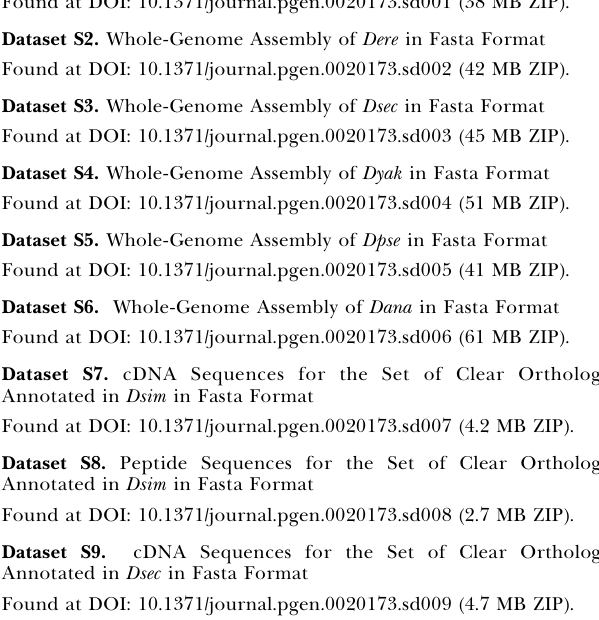
Figure S1. Significance of Incongruence under Six Evolutionary Models An excess of incongruence above what is expected by chance was observed for genes from Dmel, Dere, Dyak, and Dana using the HKY model (A), the HKY þ G model (B), the F3 3 4 model (C), the F3 3 4 þ G model (D), the WAG þ F model (E), and the WAG þ F þ G model (F). Genes were binned by bootstrap value, and the proportion of genes supporting tree 1 (red line), tree 2 (green line), and tree 3 (purple line) were plotted. The expected congruence based on the bootstrap value in each bin (black solid line) demonstrates the excess incongruence. Found at DOI: 10.1371/journal.pgen.0020173.sg001 (829 KB EPS). Figure S2. Significance of Incongruence for 20 Species Combinations An excess of incongruence above what is expected by chance was observed using the HKY model for genes from Dmel, Dsec, Dsim, Dere, Dyak, Dana, and Dpse (A), Dmel, Dsec, Dsim, Dere, Dyak, and Dana (B), Dmel, Dsec, Dsim, Dere, Dyak, and Dpse (C), Dmel, Dsec, Dere, Dyak, Dana, and Dpse (D), Dmel, Dsim, Dere, Dyak, Dana, and Dpse (E) , Dsec, Dsim, Dere, Dyak, Dana, and Dpse (F), Dsec, Dere, Dyak, Dana, and Dpse (G), Dmel, Dsim, Dere, Dyak, and Dana (H), Dsim, Dere, Dyak, Dana, and Dpse (I), Dmel, Dsec, Dere, Dyak and Dana (J), Dsim, Dere, Dyak, and Dana (K), Dsec, Dsim, Dere, Dyak, and Dana (L), Dsec, Dere, Dyak, and Dana (M), Dmel, Dsec, Dere, Dyak, and Dpse (N), Dmel, Dsim, Dere, Dyak, and Dpse (O), Dmel, Dere, Dyak, and Dpse (P), Dsec, Dsim, Dere, Dyak, and Dpse (Q), Dsim, Dere, Dyak, and Dpse (R), Dsec, Dere, Dyak, and Dpse (S), and Dmel, Dere, Dyak, Dana, and Dpse (T). Genes were binned by bootstrap value, and the proportion of genes supporting tree 1 (red line), tree 2 (green line), and tree 3 (purple line) were plotted. The expected congruence based on the bootstrap value in each bin (black solid line) demonstrates the excess incongruence. Found at DOI: 10.1371/journal.pgen.0020173.sg002 (68 KB PDF). Figure S3. RINSD Although the distributions of the RINSD for incongruent genes are biased toward lower values relative to congruent genes for the set of all genes (A), distributions are similar across trees for the set of consistent genes. Distributions were calculated using results from the original ML analysis using the F3 3 4 model and the Dmel, Dere, Dyak, and Dana species combination. Found at DOI: 10.1371/journal.pgen.0020173.sg003 (719 KB EPS). Figure S4. TSD TSD is distributed similarly across consistent and inconsistent genes (A) as well as across trees for consistent genes (B), with a slight bias toward lower values for inconsistent genes and consistent genes supporting trees 2 and 3. Distributions were calculated using results from the original ML analysis using the F3 3 4 model and the Dmel, Dere, Dyak, and Dana species combination. Found at DOI: 10.1371/journal.pgen.0020173.sg004 (701 KB EPS). Figure S5. First and Second Codon Position GC Content GC content is distributed nearly identically across species for first (A) and second (B) codon positions in all genes. Distributions were calculated using results from the original ML analysis using the F3 3 4 model and the Dmel, Dere, Dyak, and Dana species combination. Found at DOI: 10.1371/journal.pgen.0020173.sg005 (677 KB EPS). Figure S6. Sequencing Quality Scores Mean sequencing quality scores for coding nucleotides in a gene are distributed nearly identically across trees in the set of all genes for Dere (A), Dyak (B) and Dana (C). Distributions were calculated using results from the original ML analysis using the F3 3 4 model and the Dmel, Dere, Dyak, and Dana species